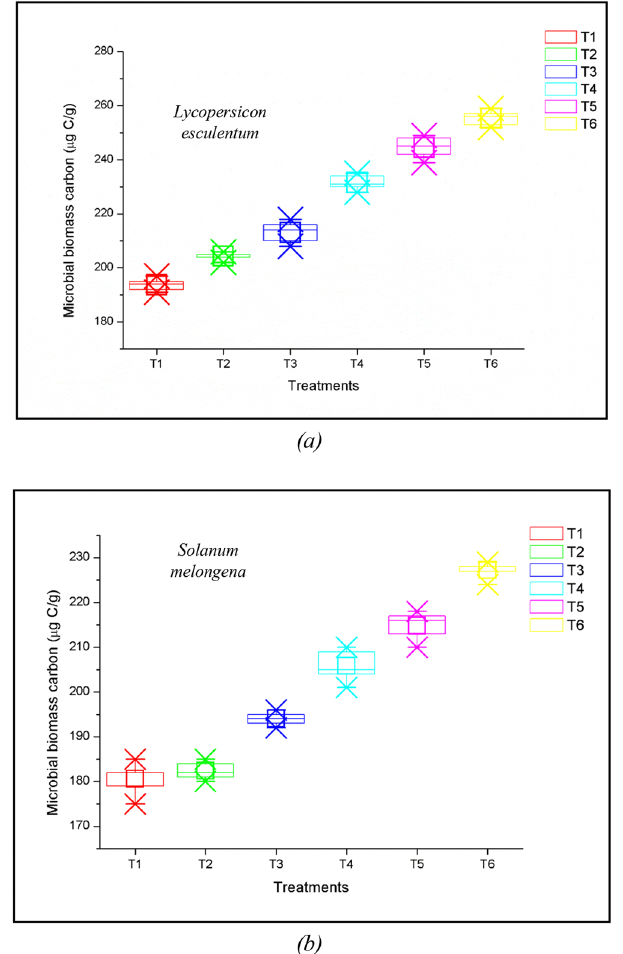
Figure 3. Variations in the microbial biomass carbon of treatments at the time of harvesting of Lycopersicon esculentum and Solanum melongena